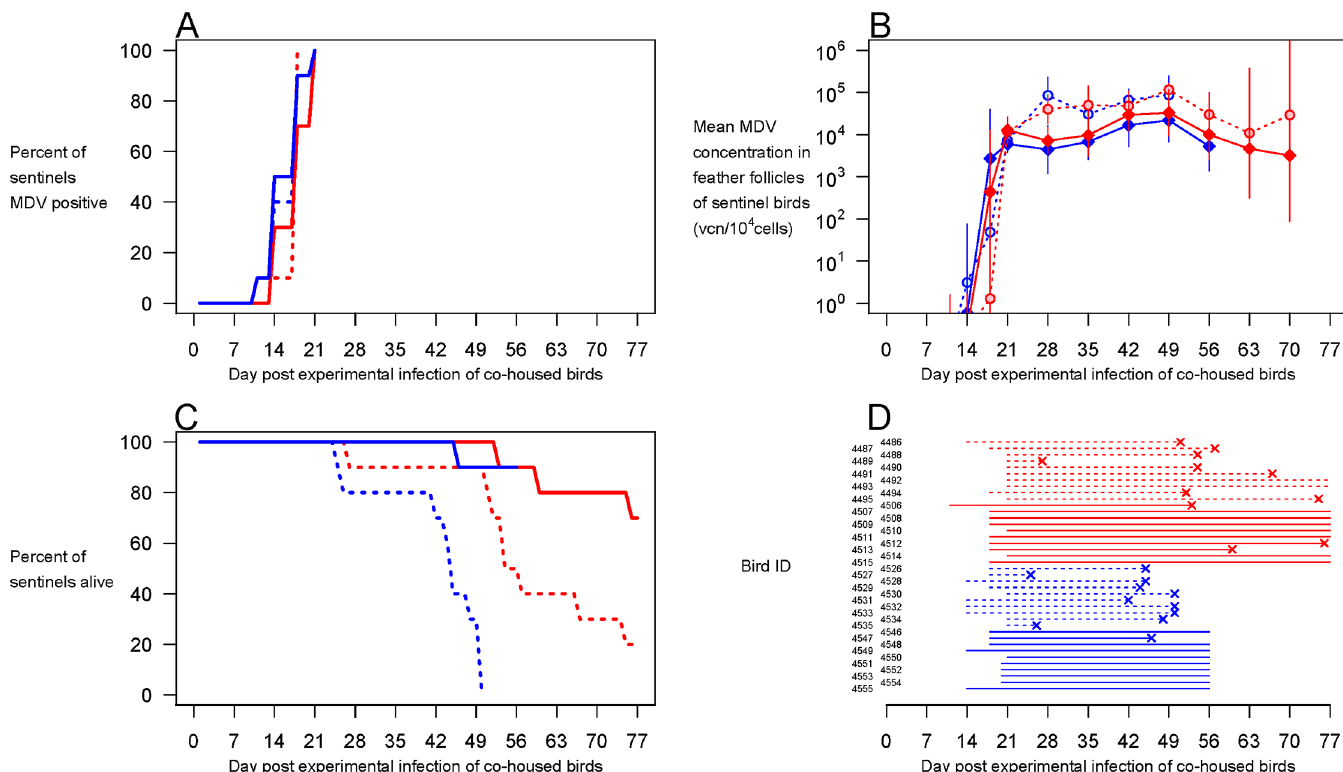
Fig 4. Transmission of hypervirulent MDV to modern commercial birds. Experiment 4. Groups of ten modern commercial broiler chicks derived from Rispens-vaccinated hens were HVT-vaccinated at 1 d of age and experimentally infected with the hypervirulent MDV strain 675A. Those experimentally infected birds were co-housed with groups of ten sentinel birds from the same commercial stock (and thus also derived from Rispens-vaccinated hens) which were HVT-vaccinated (solid lines) or not (dotted lines). The experiment was performed twice (experiment 4a, red; experiment 4b, blue). Independent of their vaccine status, all sentinel birds became infected ( A ), with high levels of virus replication in feather follicles ( B ). Vaccination prolonged the survival of sentinel birds ( C ), and consequently their infectious period ( D ). In panel D, “ x ” denotes death because of MDV. Error bars, 95% c.i. Raw data can be found at http://dx.